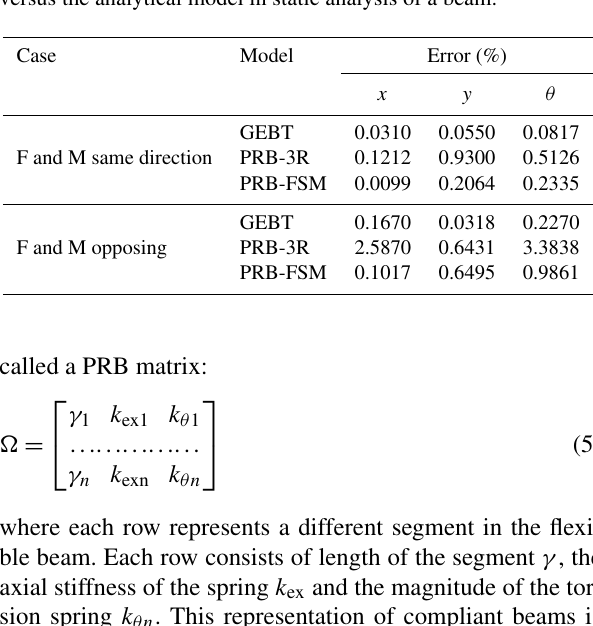
Table 1. Comparison of PRB-3R, PRB-FSM and GEBT methods versus the analytical model in static analysis of a